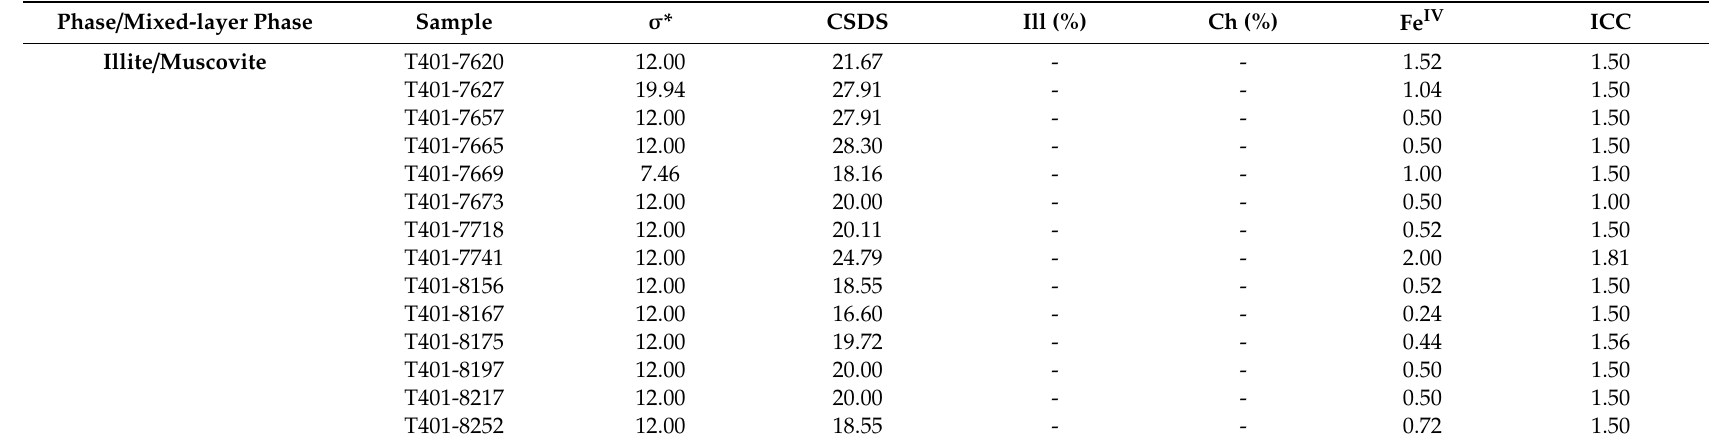
Table A3. Sybilla © parameters of main phyllosilicates and mixed-layered phases used for XRD spectra modelling of representative clay fraction samples. Phase / Mixed-layer